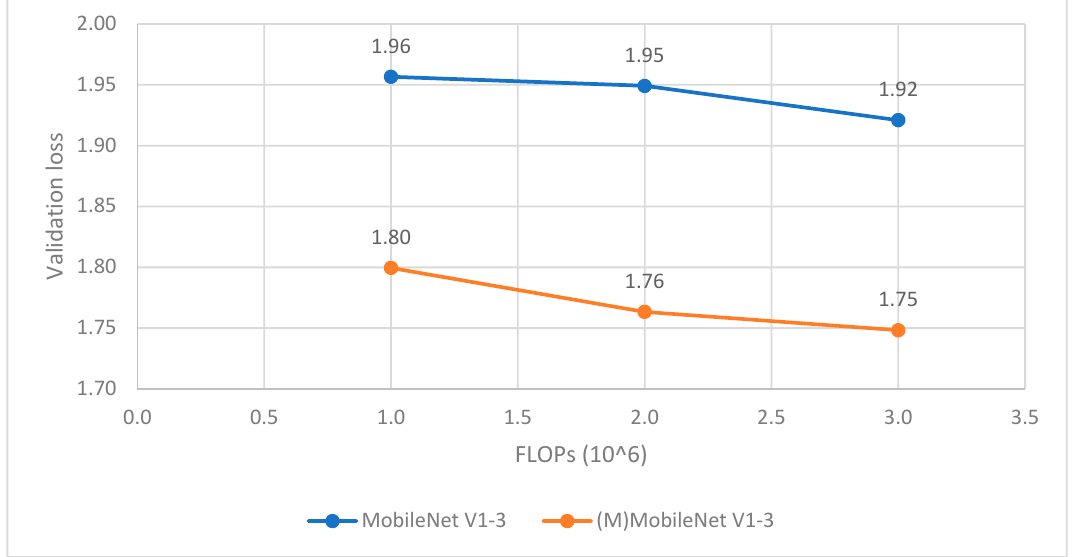
Figure 12 . Comparison between MobileNet and (M) MobileNet (V1–V3, right to left, respectively). Figure 12. Comparison between MobileNet and (M) MobileNet (V1–V3, right to left,